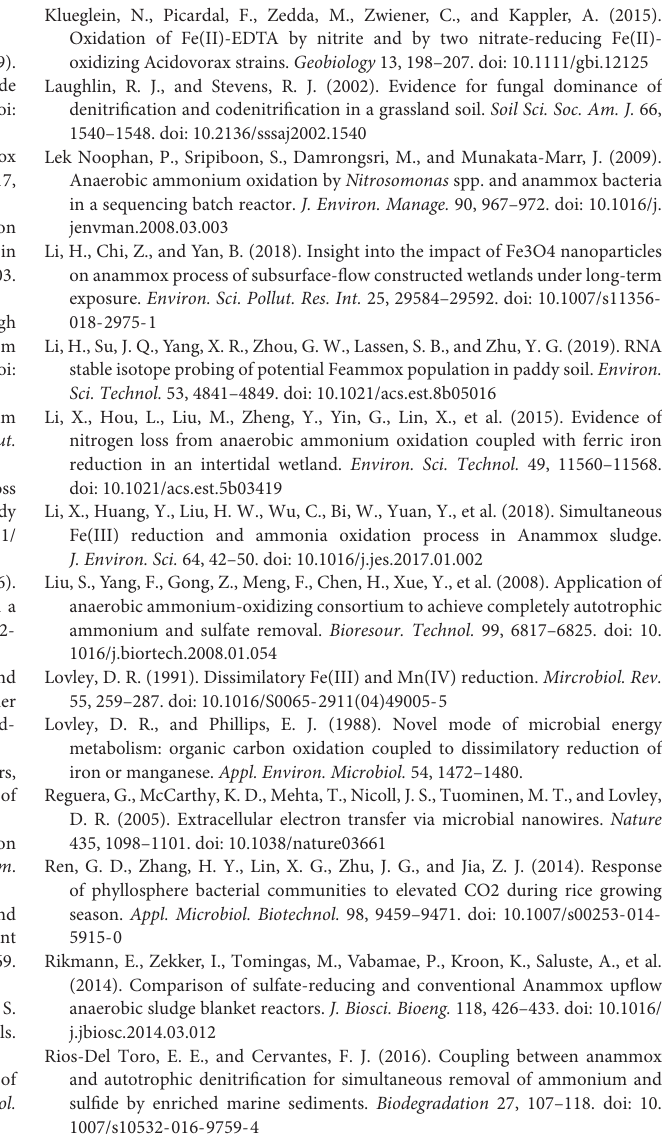
Supplementary Figure 1 | The dynamics of 29 N 2 and 30 N 2 production in the treatment of Fe(III) + NH 4 + during 22-day incubation. Supplementary Figure 2 | The time course of abundances of nirS and nosZ , and concentrations of NO 3 − and NO 2 − in the treatment of Fe(III) + NH 4 + during 22-day incubation. Supplementary Table 1 | Characteristic of the initial inoculant slurry. Supplementary Table 2 | Primers and qPCR processes used in this